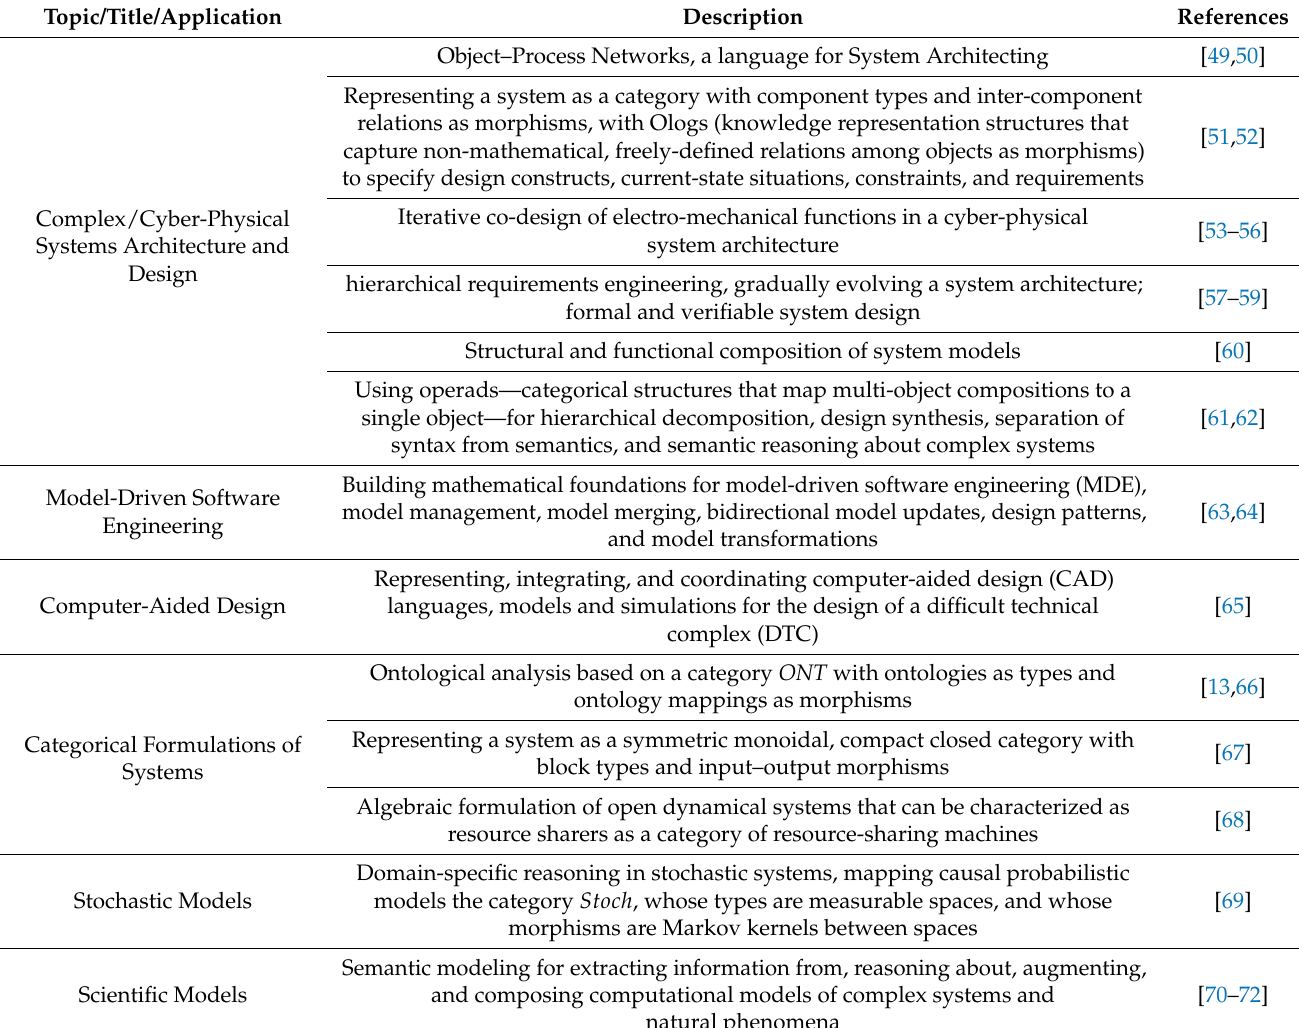
Table 2. Category Theory Applications in Systems Engineering, Analysis, and